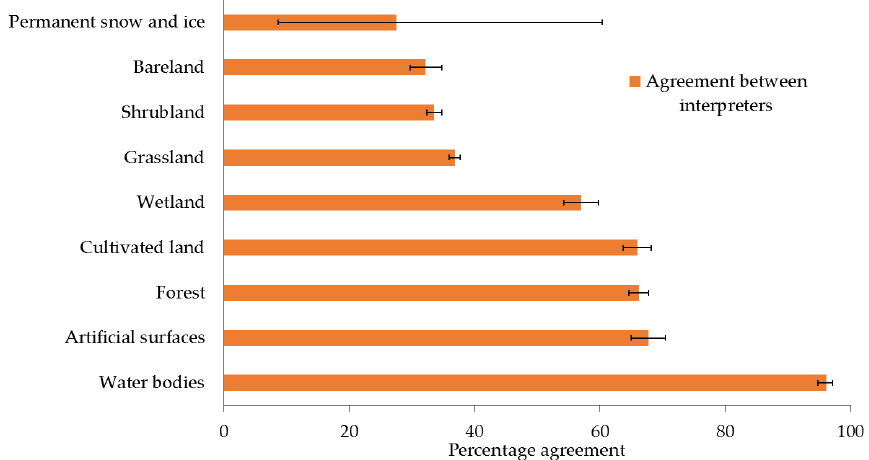
Figure 12. Agreement between interpreters showing adjusted medians and 95% confidence intervals ( n = 679).